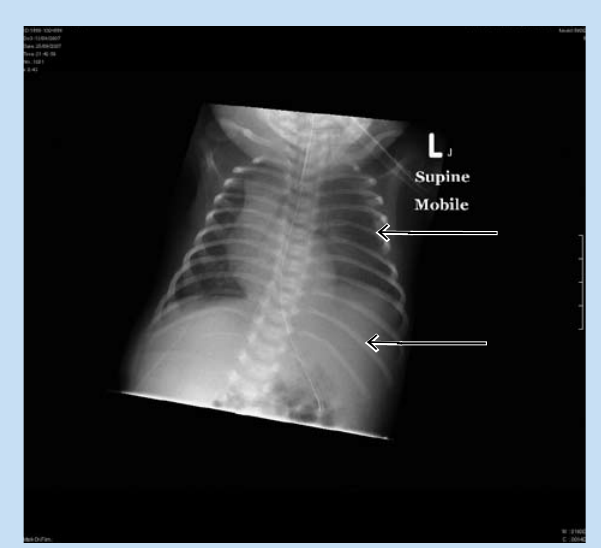
Fig. 1a. CXR demonstrates left subphrenic mass (arrow) displacing nasogastric tube in stomach inferiorly. Left-sided effusion present (arrow-